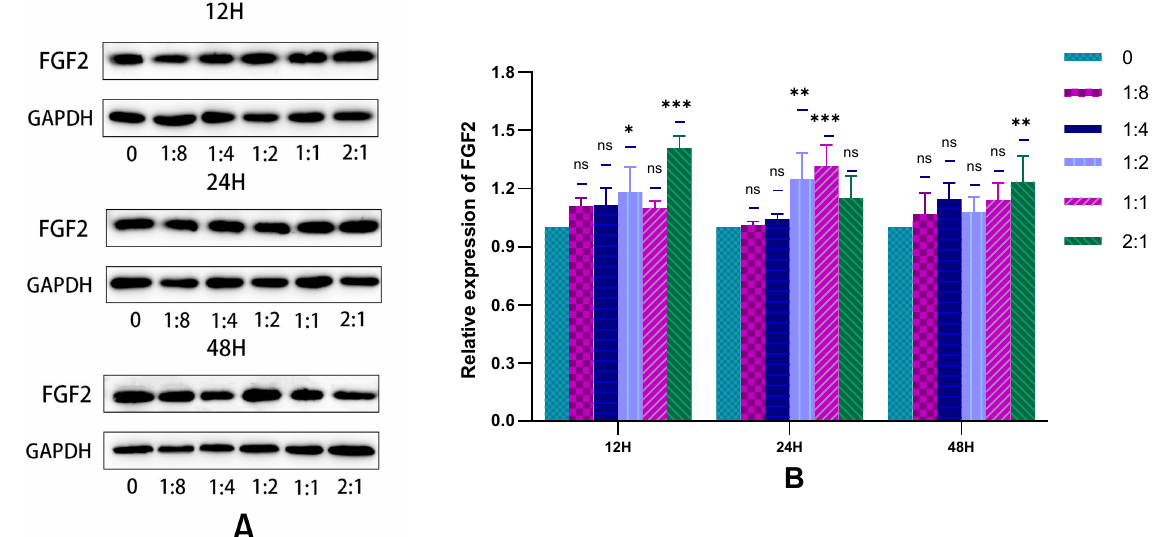
Figure 9. In the cell co-culture system, the WB detection map of VEGFA protein secreted by HSFs. ( A) The WB map of VEGFA protein secreted by HSFs after cell co-culture for 12 h, 24 h, and 48 h. ( B ) The statistical results of relative expression of VEGFA protein secreted by HSFs. ns: p > 0.05, *: p < 0.05, **: p < 0.01.